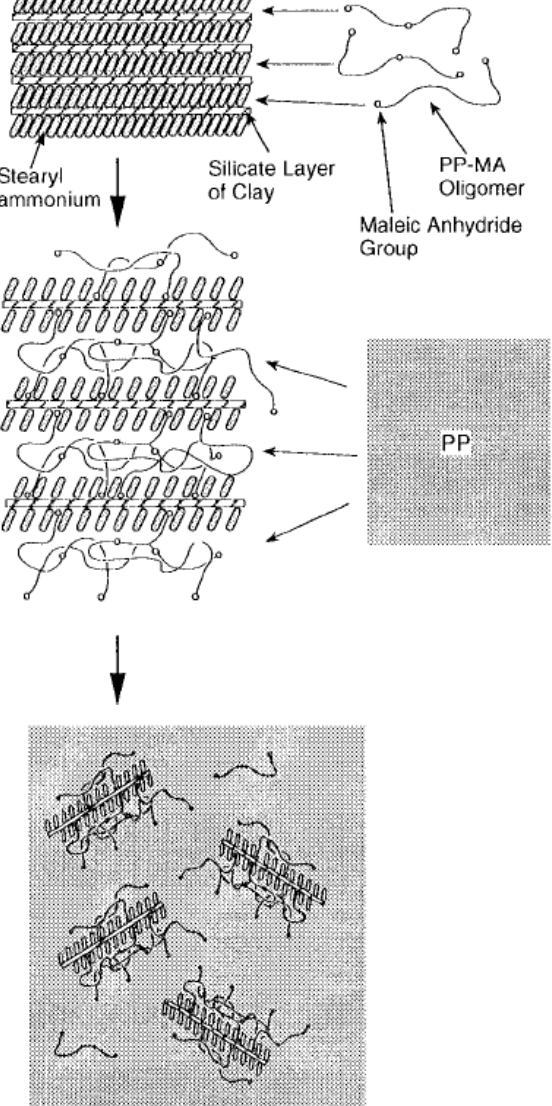
Figure 23. Schematic of polymer intercalation in the silicates in the presence of PP-g-MA. Reproduced from reference [108] with permission from The American Chemical